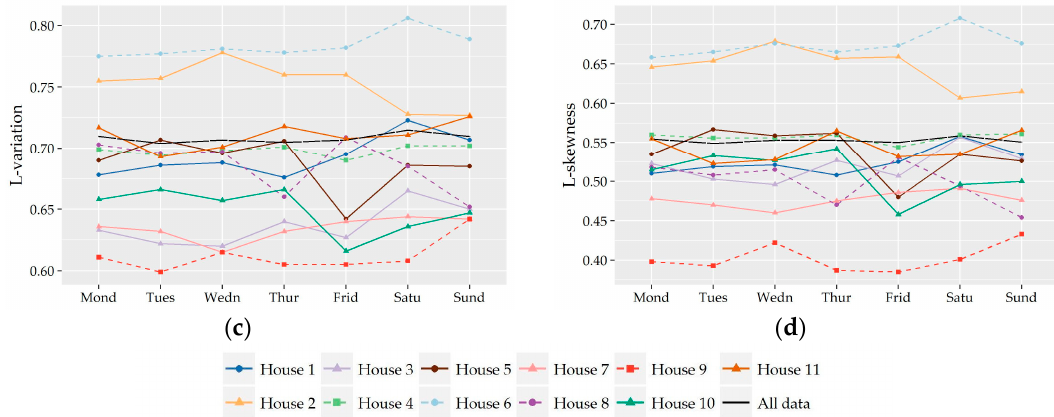
Figure A2. 15 min scale : Variation per day of the probability of no demand ( a ), mean value ( b ), L- variation ( c ), and L-skewness ( d ) of the 15-min nonzero demand records.